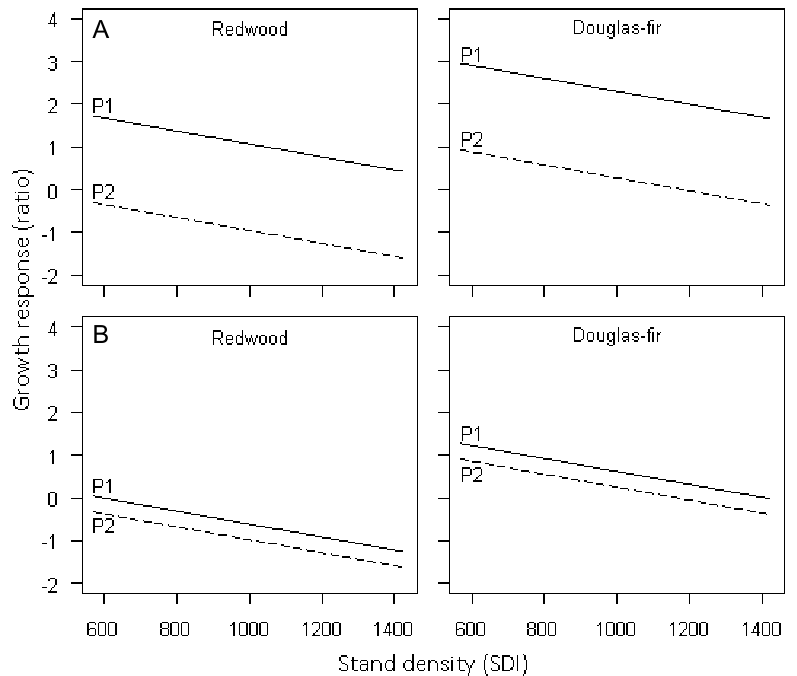
Figure 5. Redwood and Douglas-fir branch growth response to increasing post-treatment SDI for harvest + herbicide ( A ), and herbicide ( B ) plot types in the first 5-year period (P1) and second 5-year period (P2) after treatment in Mendocino County, California. Model variable SDI removed was fixed at the means for each plot type to show relationship between BGR and metric SDI.